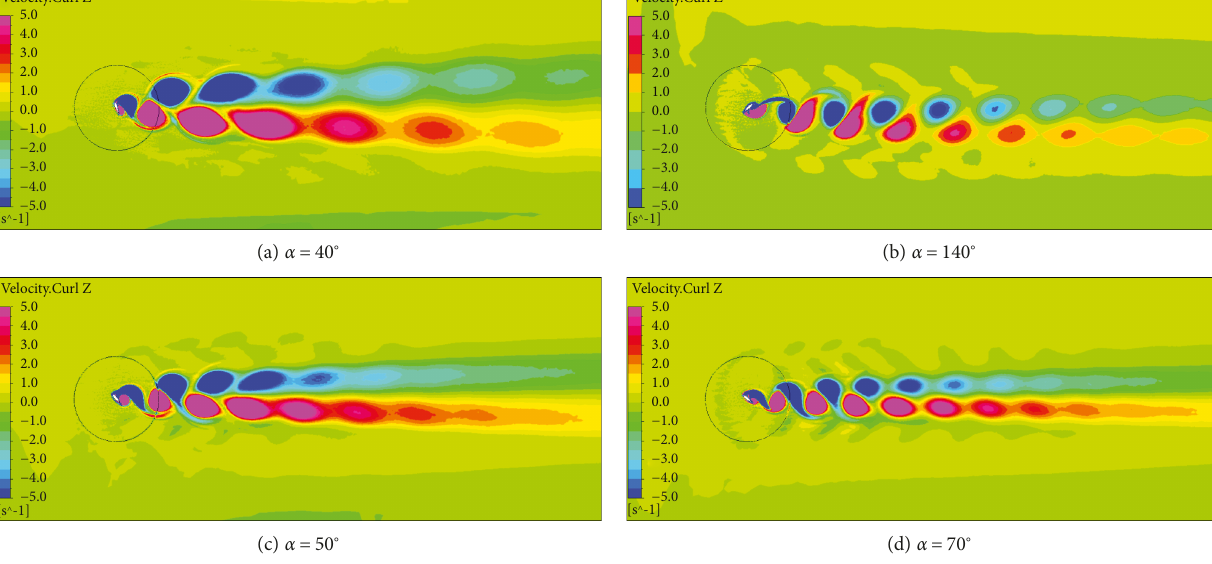
Figure 7: Instantaneous vorticity magnitude at di ff erent incidences for static airfoil, t = 10 s, showing di ff erent vortex street structures, counter-clockwise (positive) vorticity (in pink), and clockwise (negative) vorticity (in